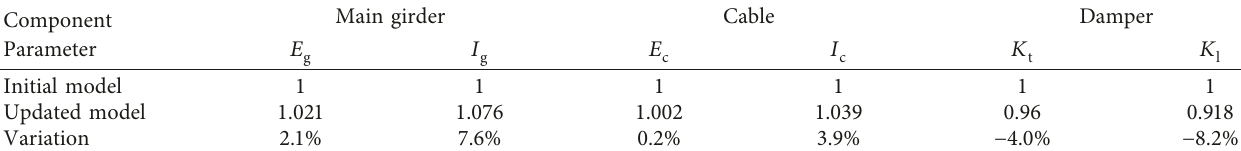
Table 2: Variation of parameters.